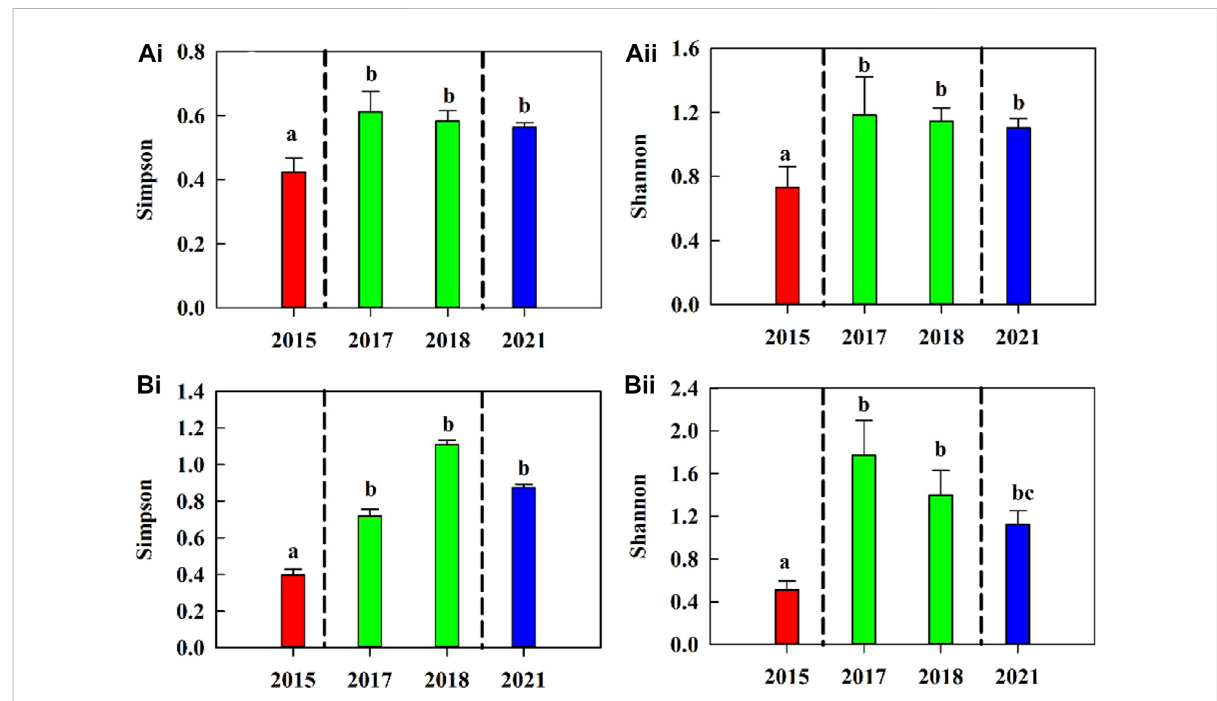
FIGURE 5 Temporalandspatial variation characteristics ofspeciesdiversity intheupperandmiddle reachesofthemainstream oftheTarimRiver. (Ai,Aii) is Shaya Populus euphratica Forest Park, (Bi, Bii) is Luntai Populus euphratica Forest